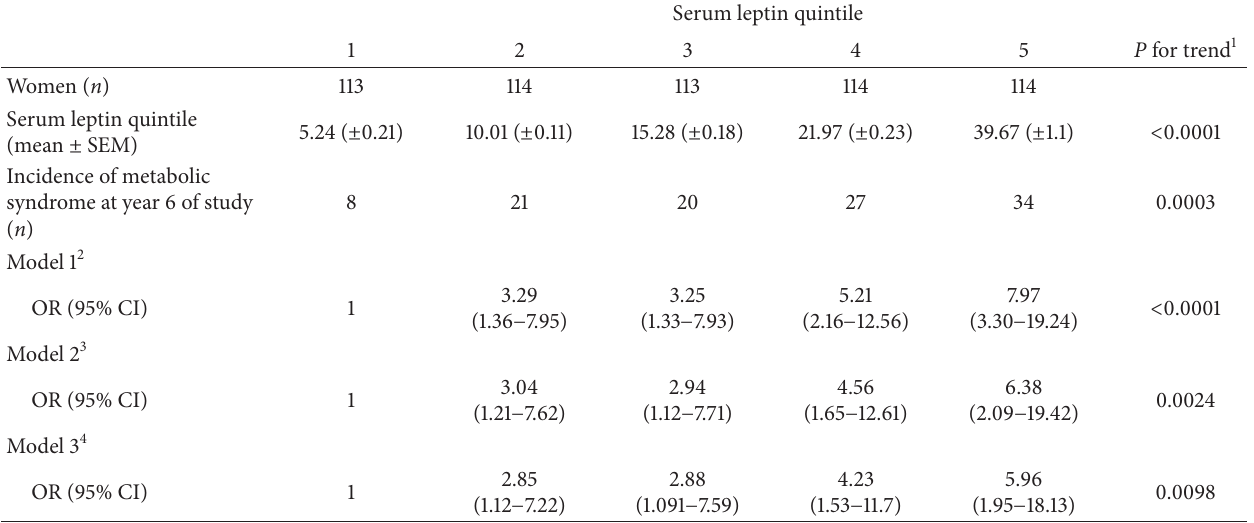
Table 4: Adjusted odd ratios (OR) of the incidence of metabolic syndrome at year 6 by serum leptin quintile among women. Serum leptin quintile